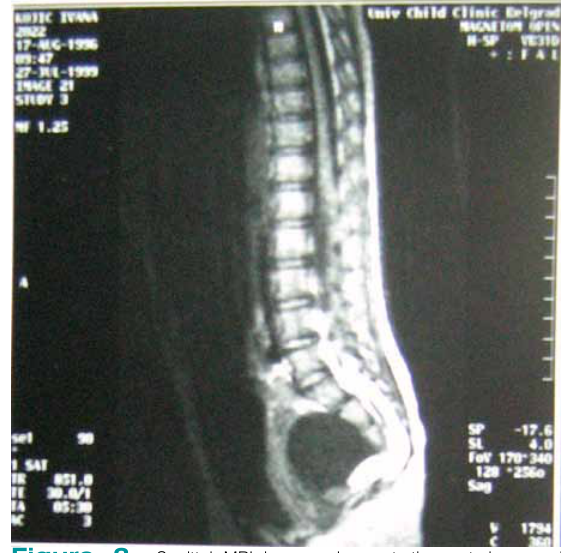
Figure 3. Sagittal MRI images demonstrating anterior sacral